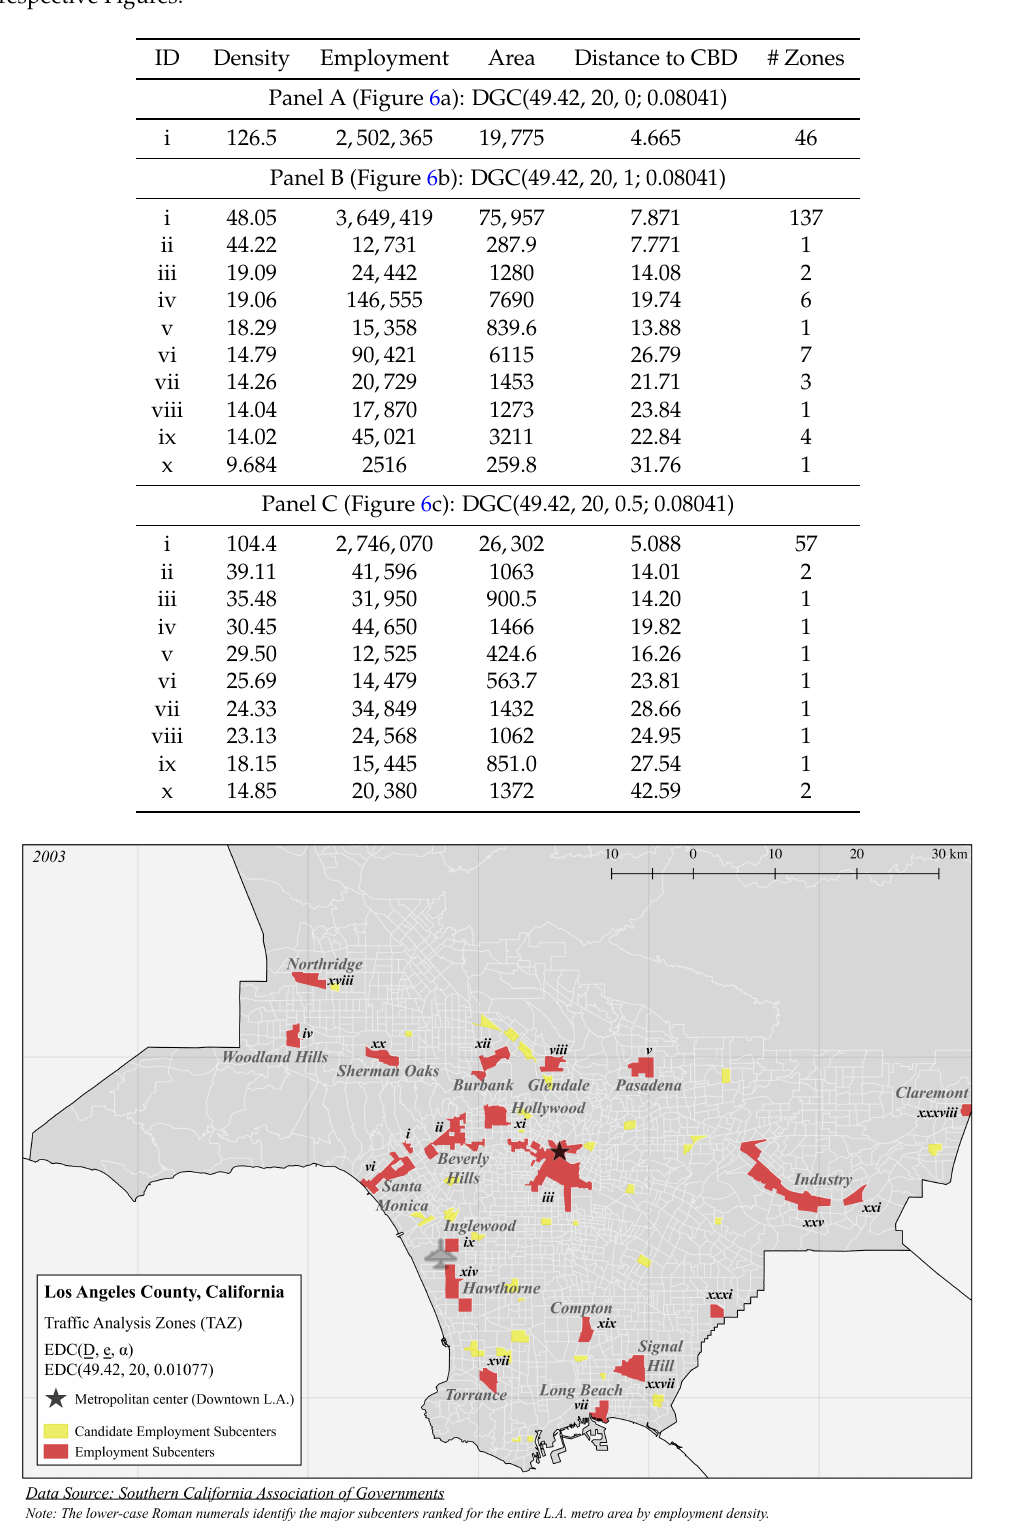
Table A4. Paris Metropolitan Area subcenters. Density = employees per hectare; area = hectares; distance to CBD = kilometers; and # zones indicate Communes; IDs link subcenters to their location in respective Figures.